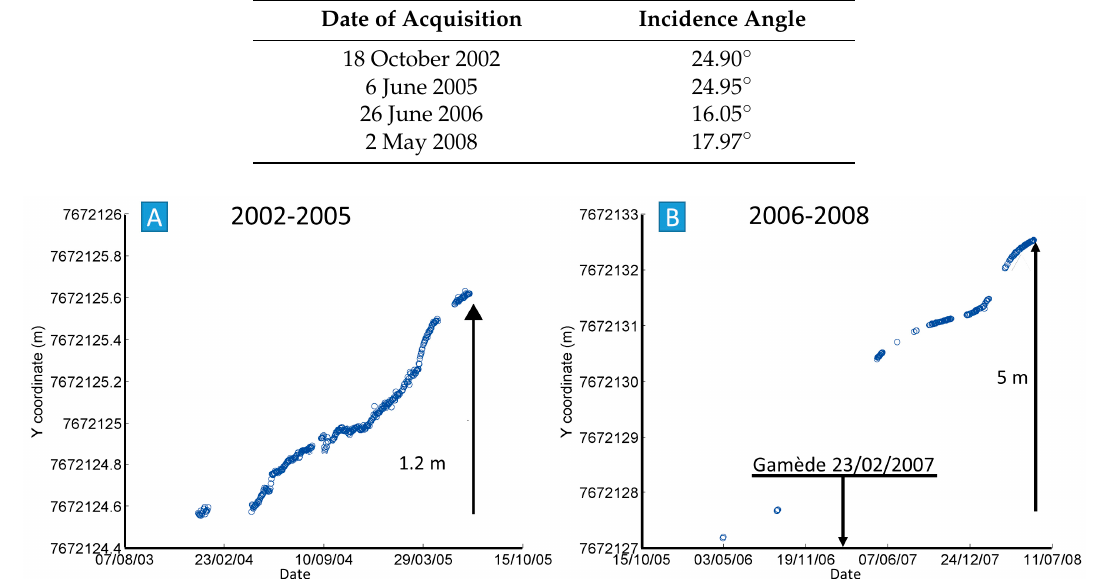
Figure 2. ( A ) N-S position of the Vira DGPS control point in UTM 40 S projection for the two study periods. The displacement is approximately 1.2 m toward the north from January 2004 to May